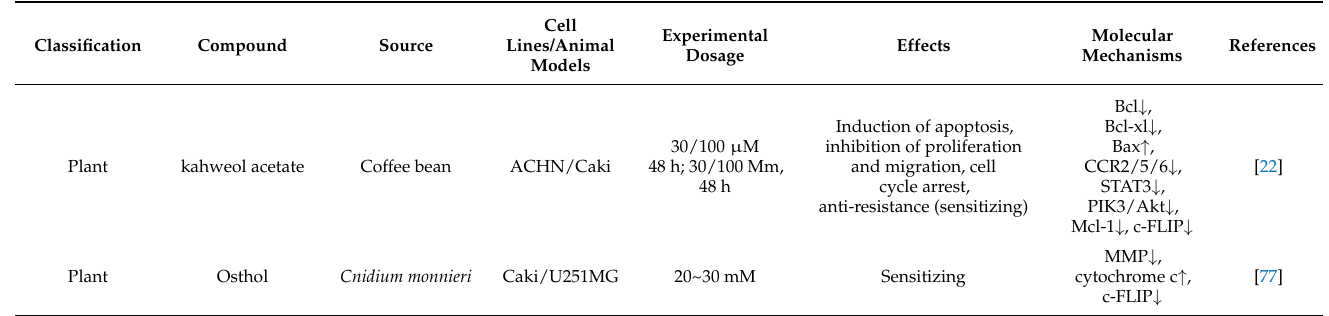
Table 4. Natural products showing drug sensitizing effect in renal cell